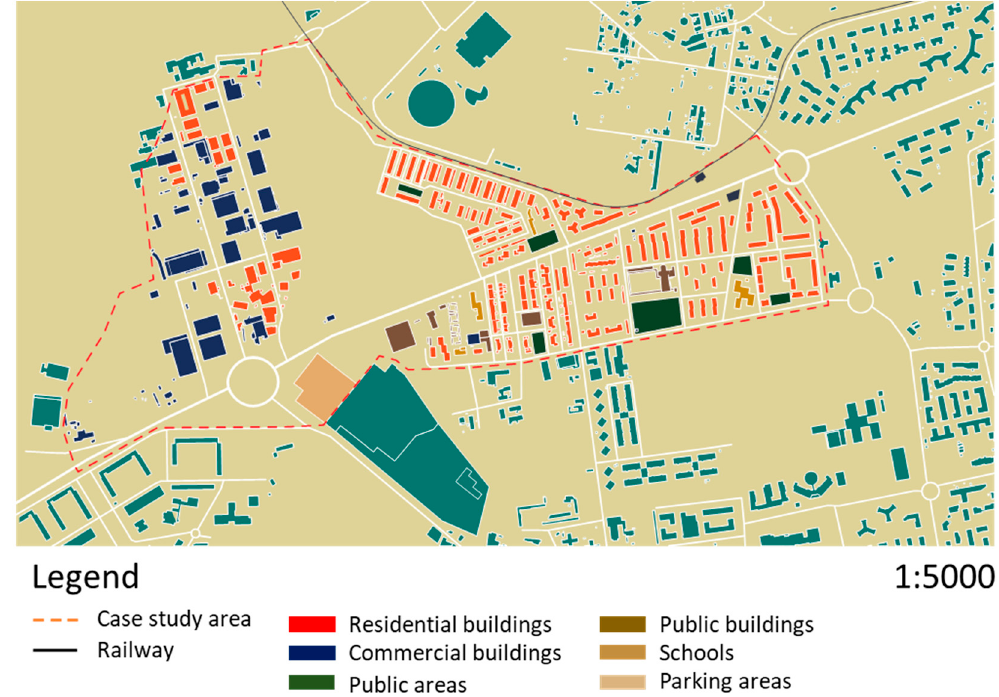
Figure 4. Destination use of the buildings in the case study area.